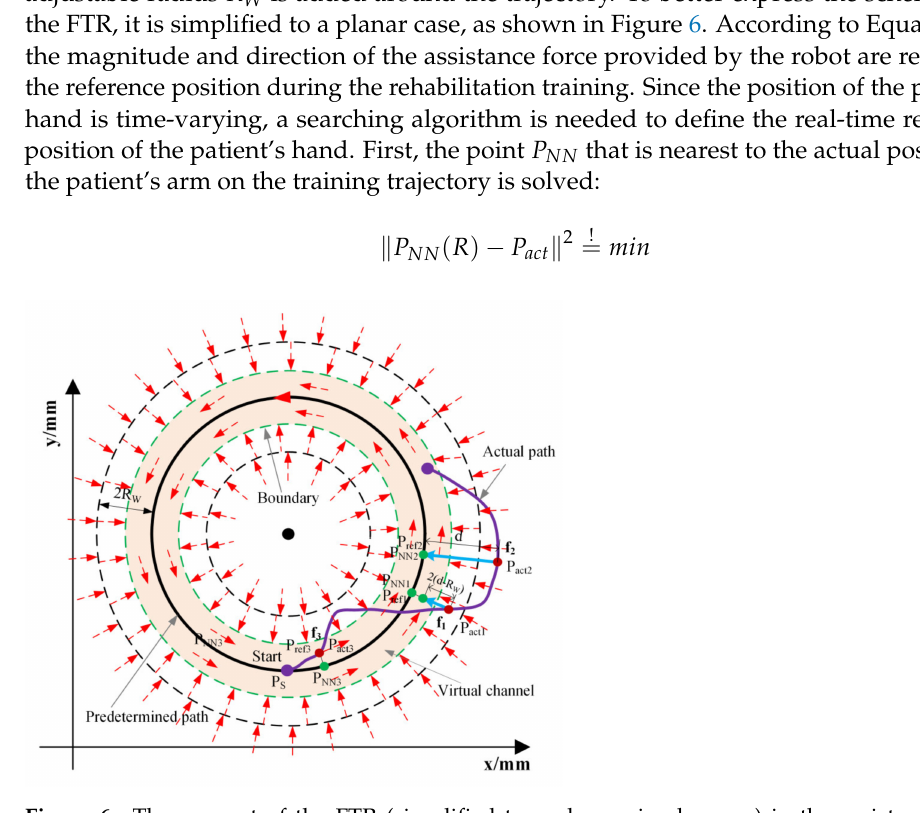
Figure 6. The concept of the FTR (simplified to a planar circular case) in the assist-as-needed (AAN)